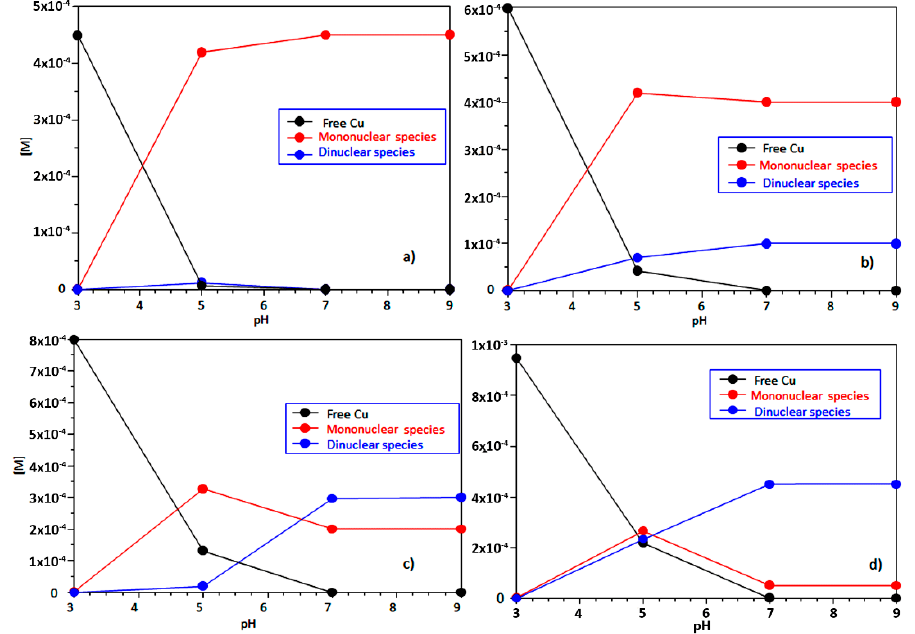
Figure 2. Total concentration of Cu 2+ -Ctr1 (1-14) mononuclear and binuclear complexes species at Cu 2+ /Ctr1 (1-14) concentration ratios equal to 0.9, 1.2, 1.6 and 1.9 for ( a – d ), respectively.